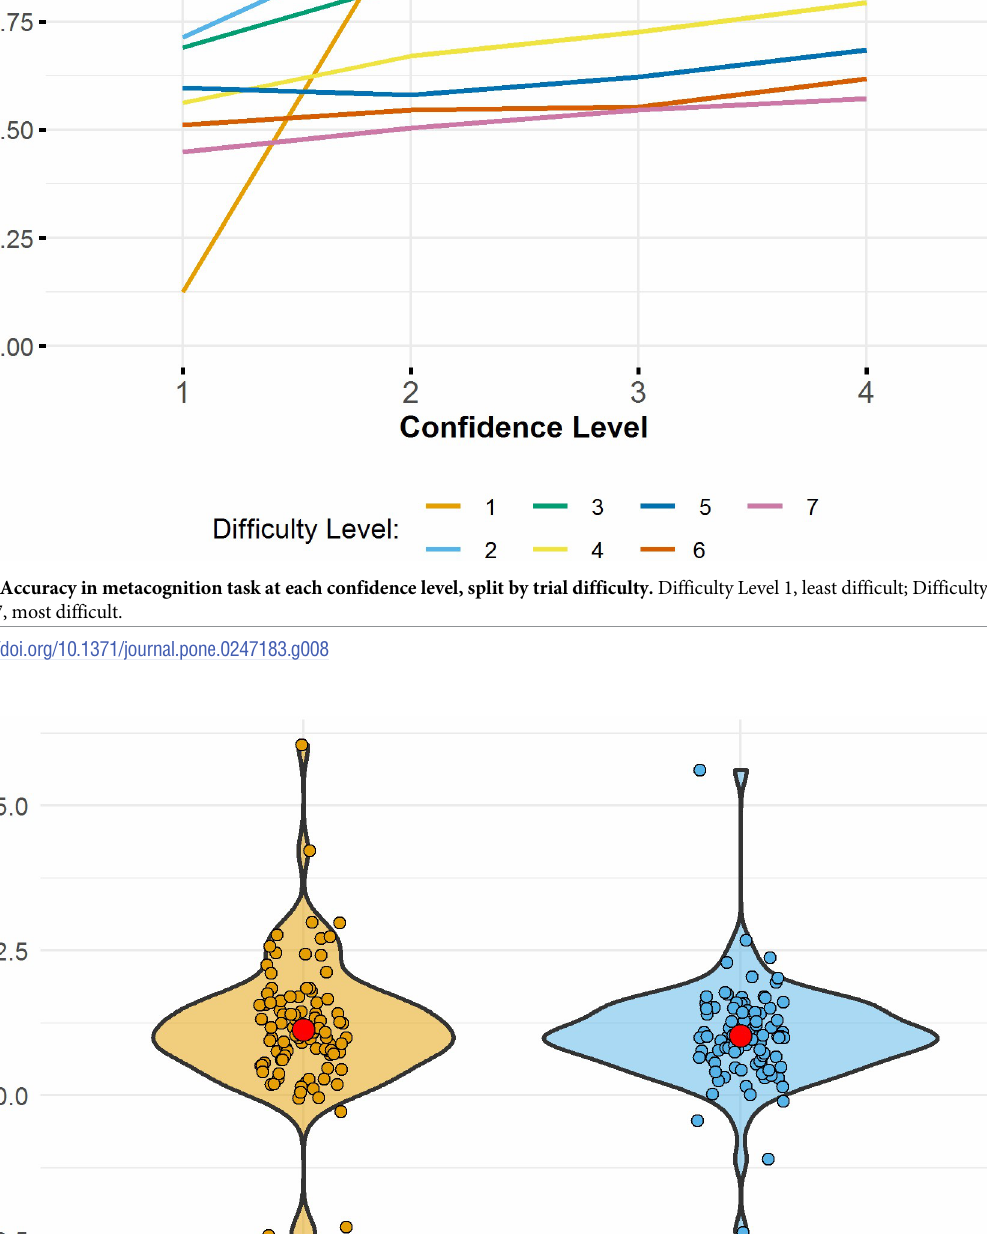
PLOS ONE | https://doi.org/10.1371/journal.pone.0247183 March 4,